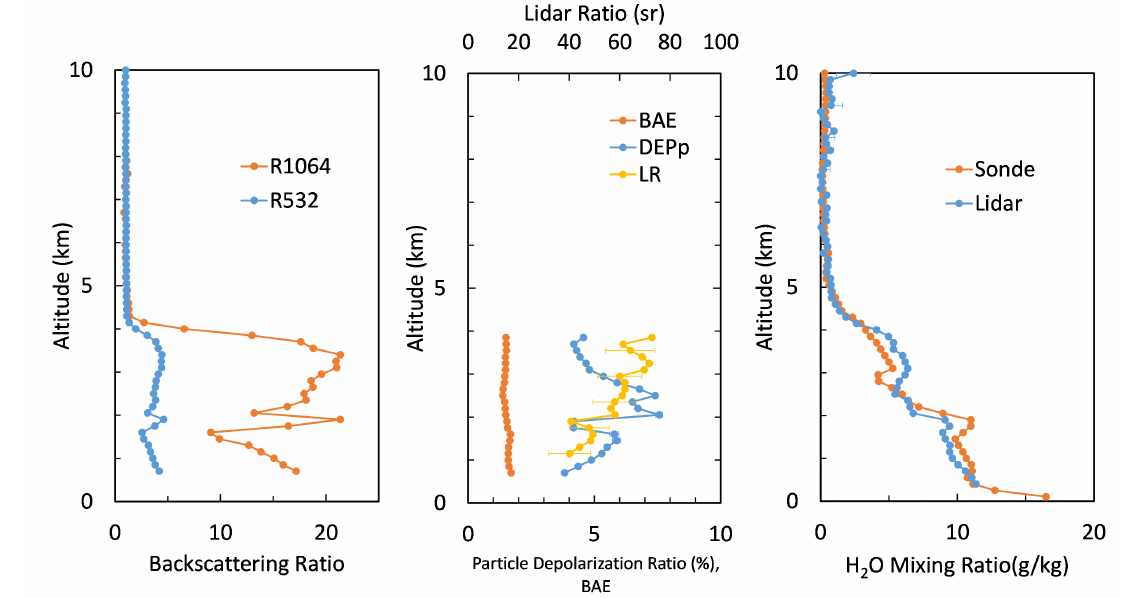
Figure 5. Vertical profiles of backscattering ratios at 1064 nm (R1064) and 532 nm (R532) ( left ), backscatter-related Ångström exponent (BAE), particle depolarization ratio (DEPp), LiDAR ratio (LR) ( center ) and water vapor mixing ratio measured by LiDAR and radiosonde (but over Laoag) ( right ) over Burgos on 8 March 2017. Horizontal bars represent the error bars of respective physical